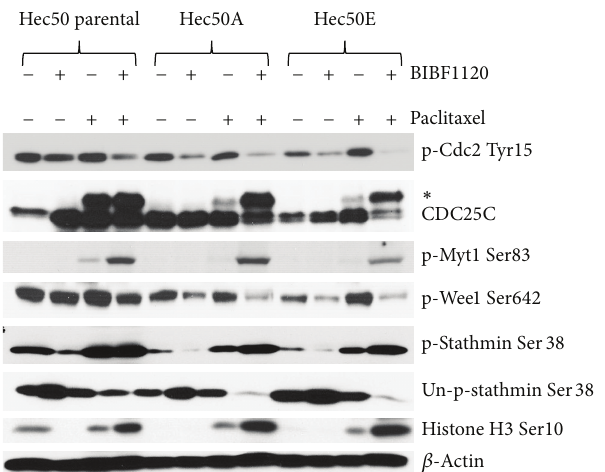
Figure 5: BIBF1120+paclitaxel modifies G2/M checkpoint controllers to induce transition into M phase. The effect of 1 𝜇 M BIBF1120, 14nM paclitaxel, and combination treatment (24 h) on the posttranslational modification of cell cycle regulators was examined by Western blotting. ∗ denotes slower-migrating CDC25C, indicative of activating